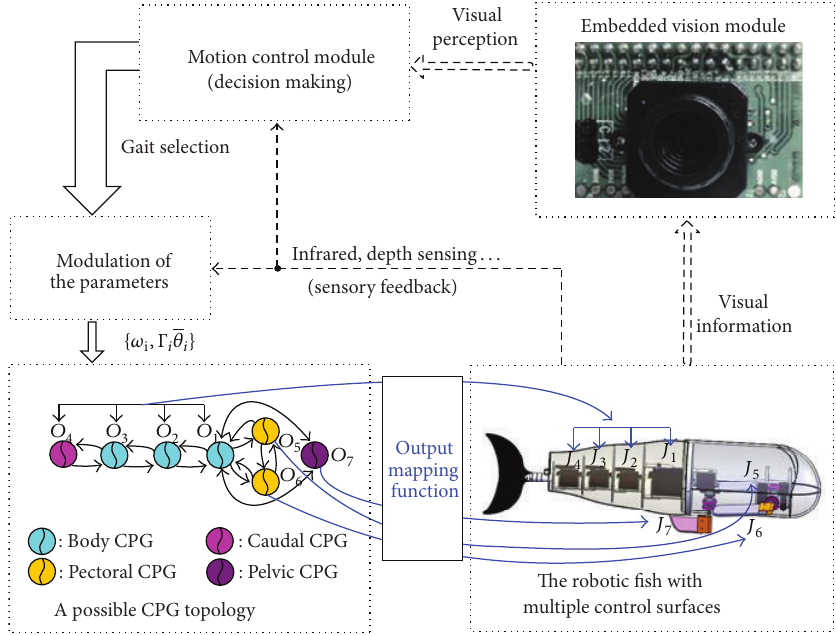
Figure 3: Diagram of the complete control